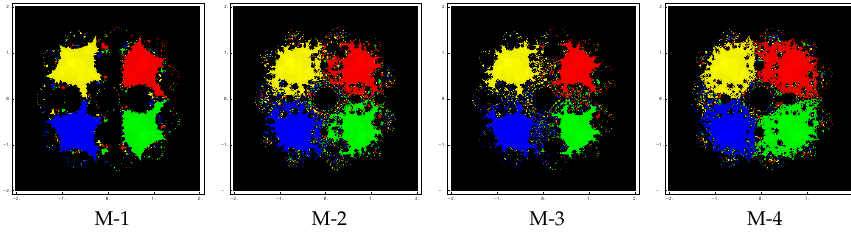
Figure 7. Basins of attraction by M-1–M-4 ( β = 0.01 ) for polynomial ψ 3 ( z ) .